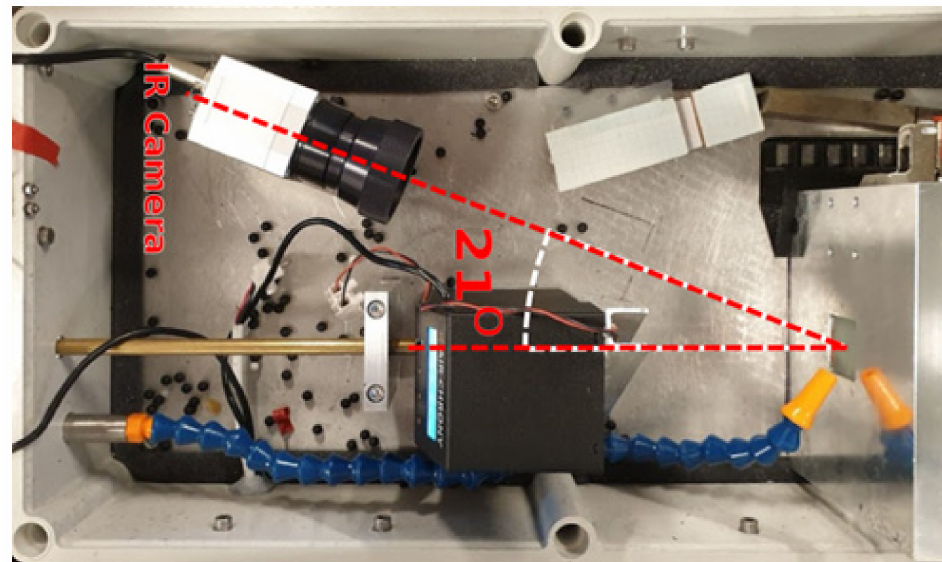
Figure 3. The arrangement of the IR camera in test setup.